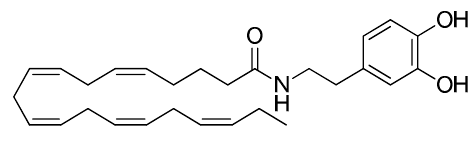
Figure 1. N -Eicosapentaenoyl dopamine (EPDA).